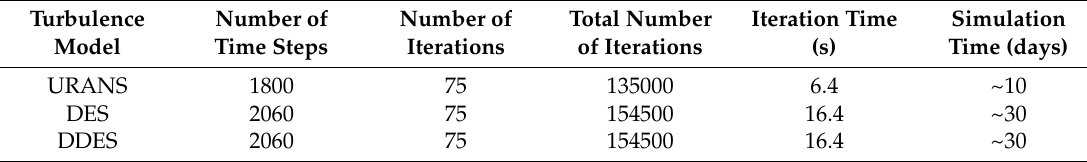
Table 4. Computational cost per rotation of the turbine for different turbulence